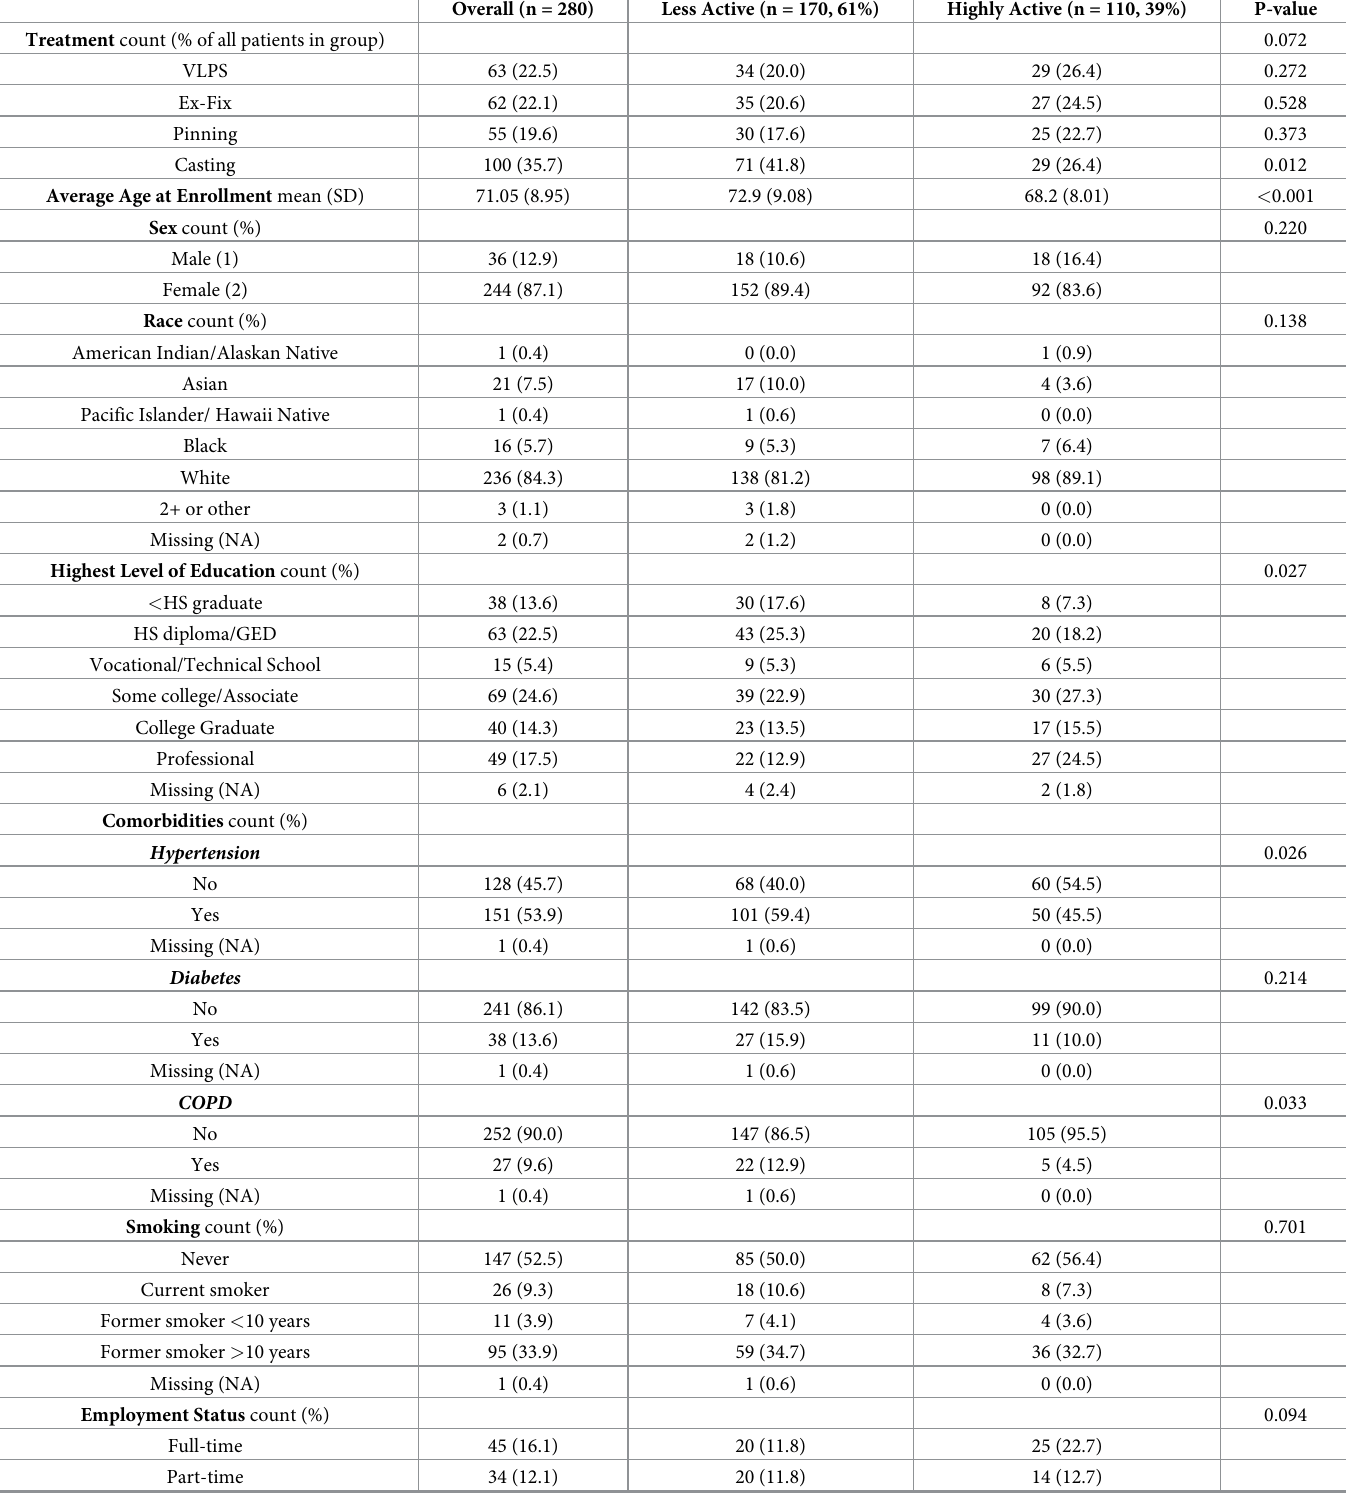
Table 2. Demographic characteristics of highly and less-active